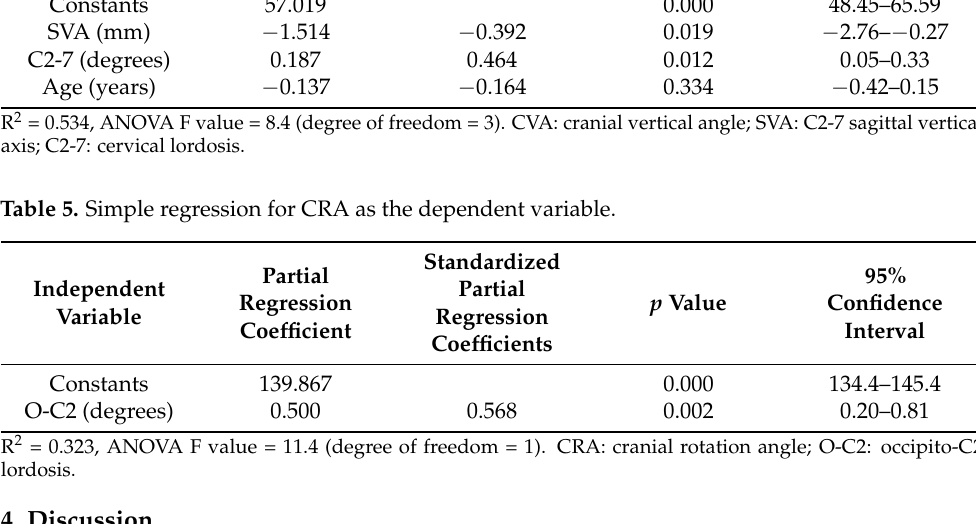
Table 4. Multivariate regression for CVA as the dependent variable. Partial Independent Variable